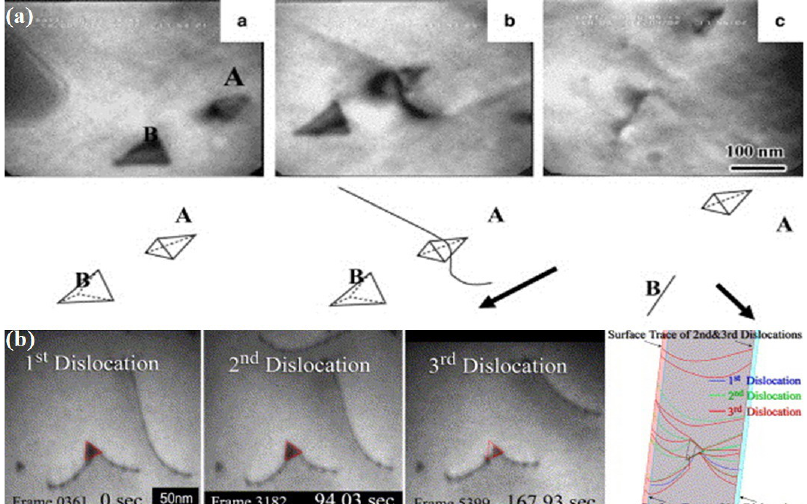
Figure 7. (color online) In situ observation of the annihilation of SFTs through the interaction with sliding dislocations. ( a ) The SFT labeled “B” collapses into a glissile dislocation with the remnant dislocation gliding away in gold. (Reprinted with permission from [62]. Copyright 2005 by Elsevier.) ( b ) The SFT is annihilated through a sequential interaction with sliding dislocations. (Reprinted with permission from [63]. Copyright 2004 by